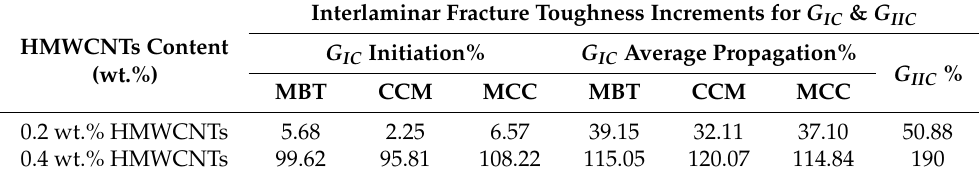
Table 4. Mode I and mode II interlaminar fracture toughness